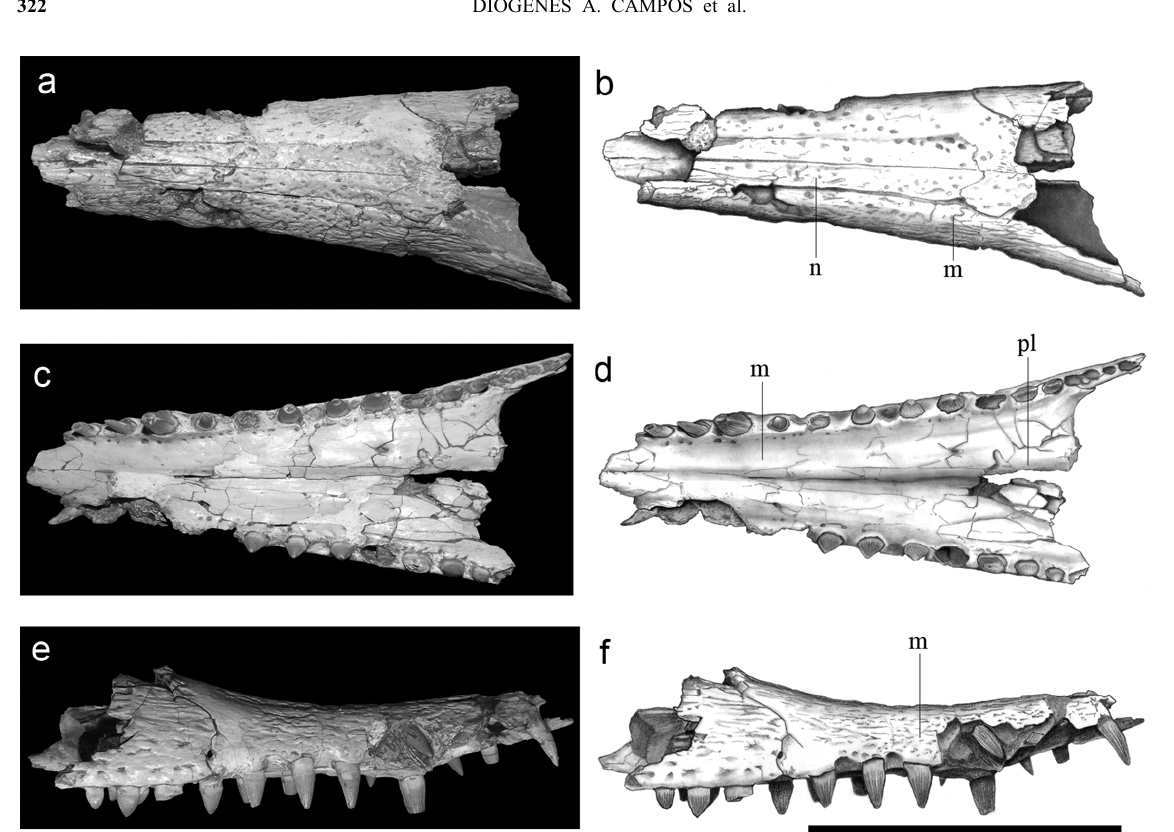
Fig. 3 – Paratype (MCT 1788 – R) of Pepesuchus deiseae gen. et sp. nov. in dorsal, ventral and lateral views. Scale bar: 100 mm. Abbreviations: m – maxilla, n – nasal, pl –